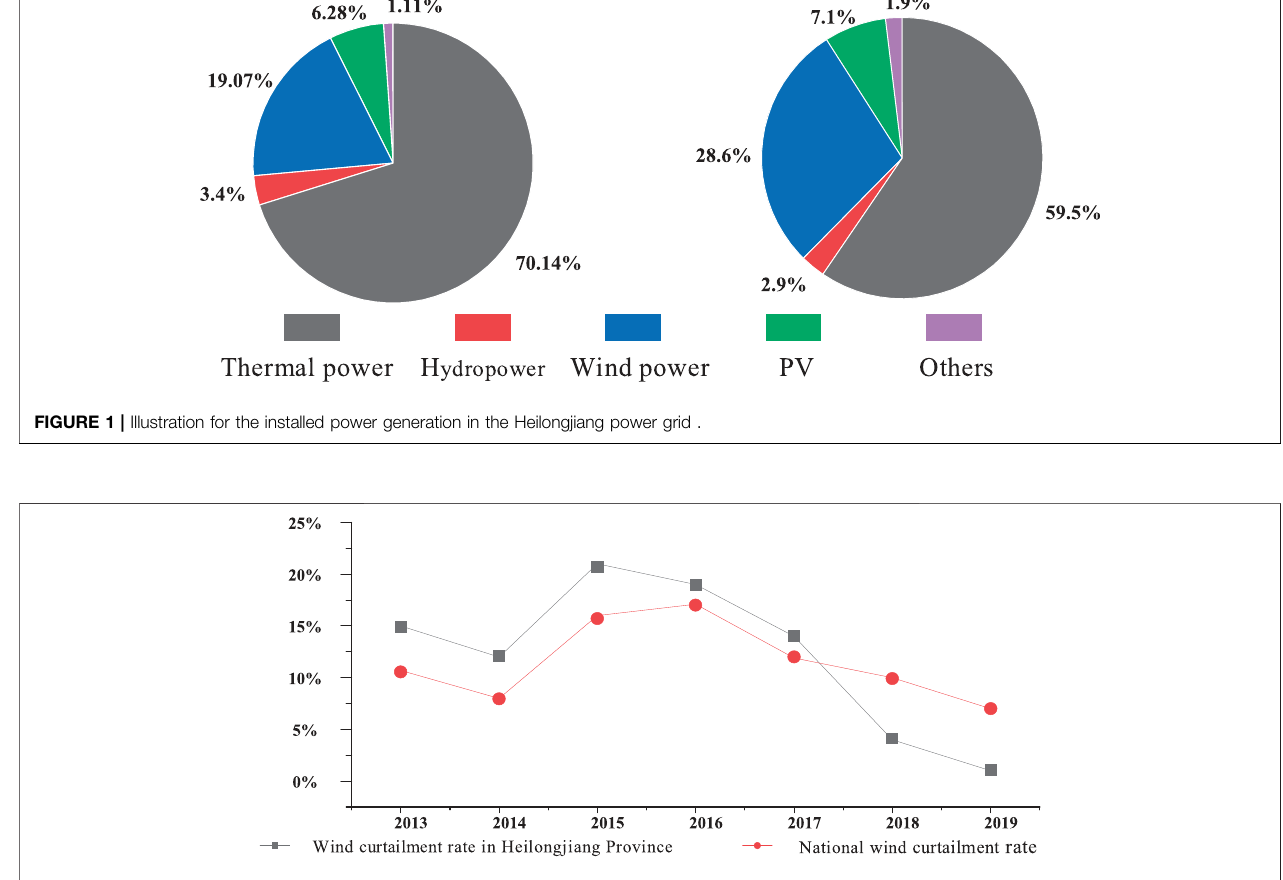
FIGURE 2 | Wind curtailment rate in Heilongjiang